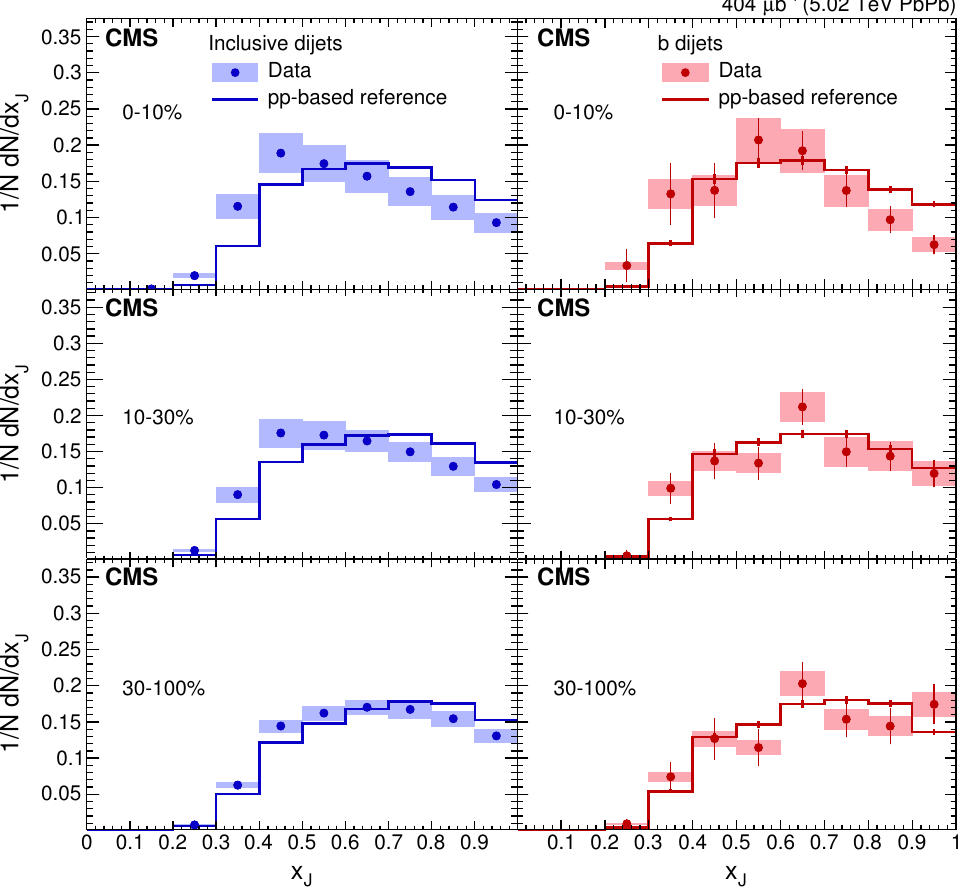
Figure 5 . Distributions of x J in PbPb collisions for inclusive dijets (left) and b dijets (right). Systematic uncertainties are shown as shaded boxes, while statistical uncertainties are shown as vertical lines. The top, middle and bottom rows show the 0{10, 10{30 and 30{100% centrality selections, respectively. The data are compared to a reference obtained by smearing pp according to the jet resolution for the given centrality class, as described in the